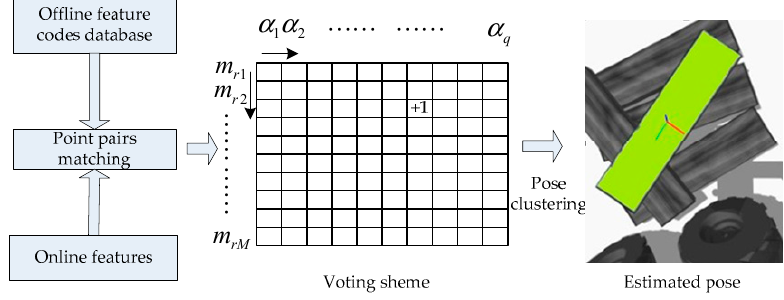
Figure 10. The final pose determination process of the plank.